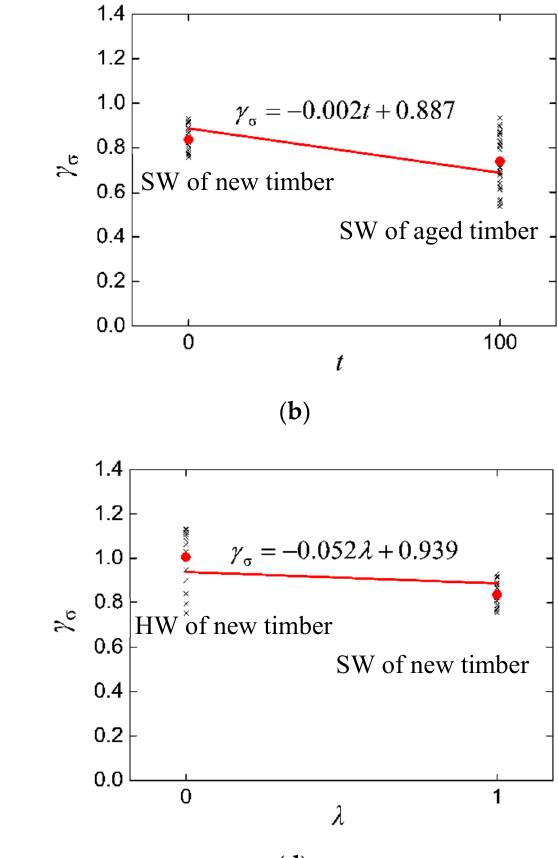
where λ denotes the relative distance between the sampling location of the standard specimen and the centroid of the timber cross-section. The equations defining the four edges of the plane (dashed lines in Figure 6a) are shown in Figure 7. The solid dots in the plots represent the sample means of the data groups. Each sample mean is close to one end of the straight line, indicating a good representation of the fitted plane.